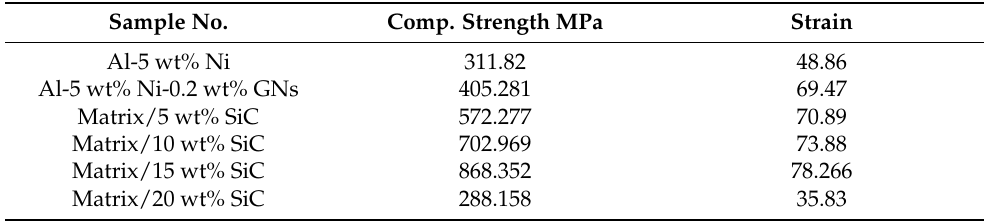
Table 3. Compressive stress and strain of the tested samples.